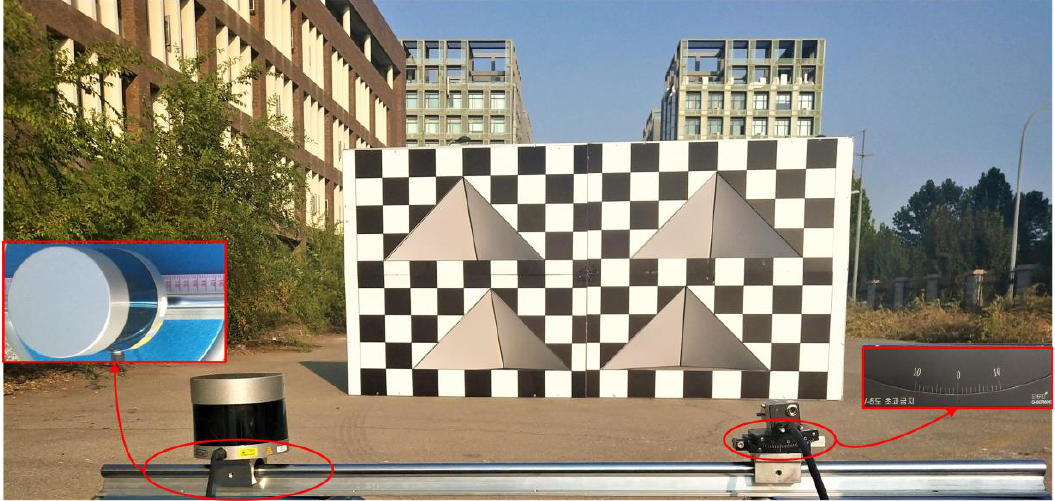
Figure 6. Experimental system and test scenario.